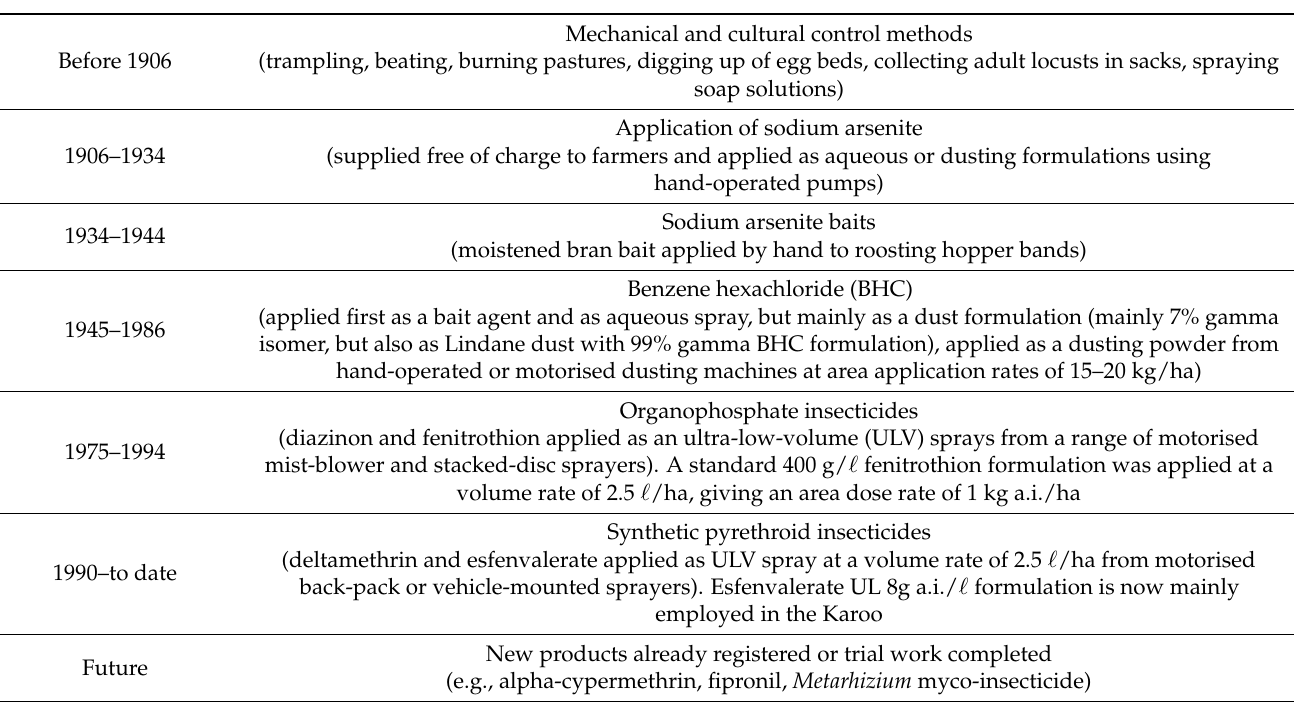
Table 2. History of the methods and insecticide products used for brown locust control operations in South Africa (from the South African National Department of Agriculture and